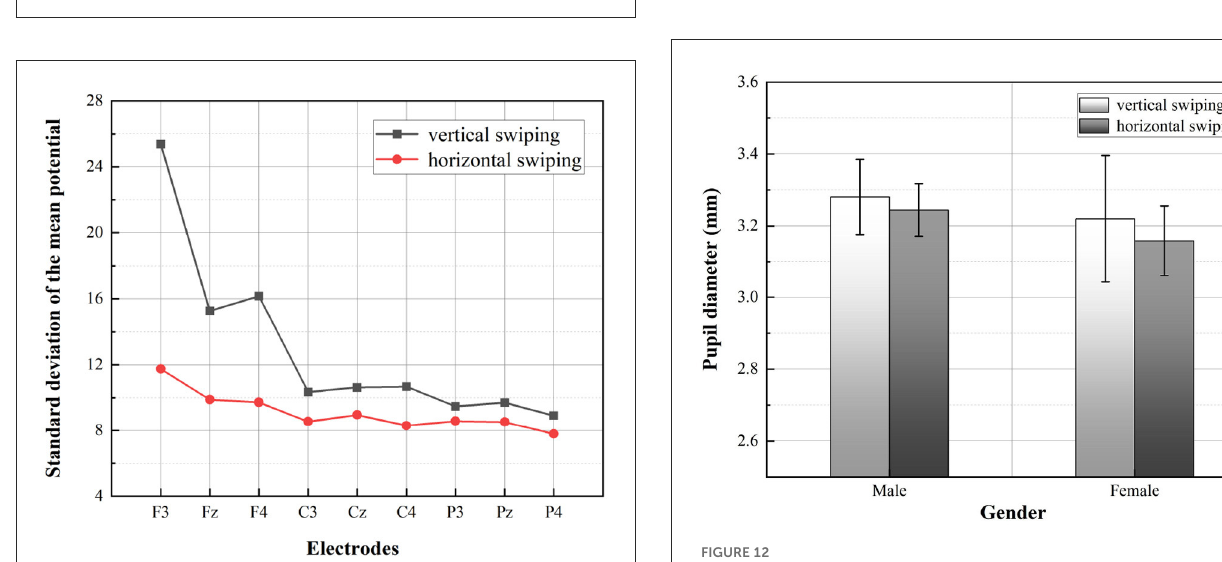
FIGURE9 Statistics for males in two swiping directions. The standard deviation of the mean potential at the different electrodes for the two swiping directions are depicted.